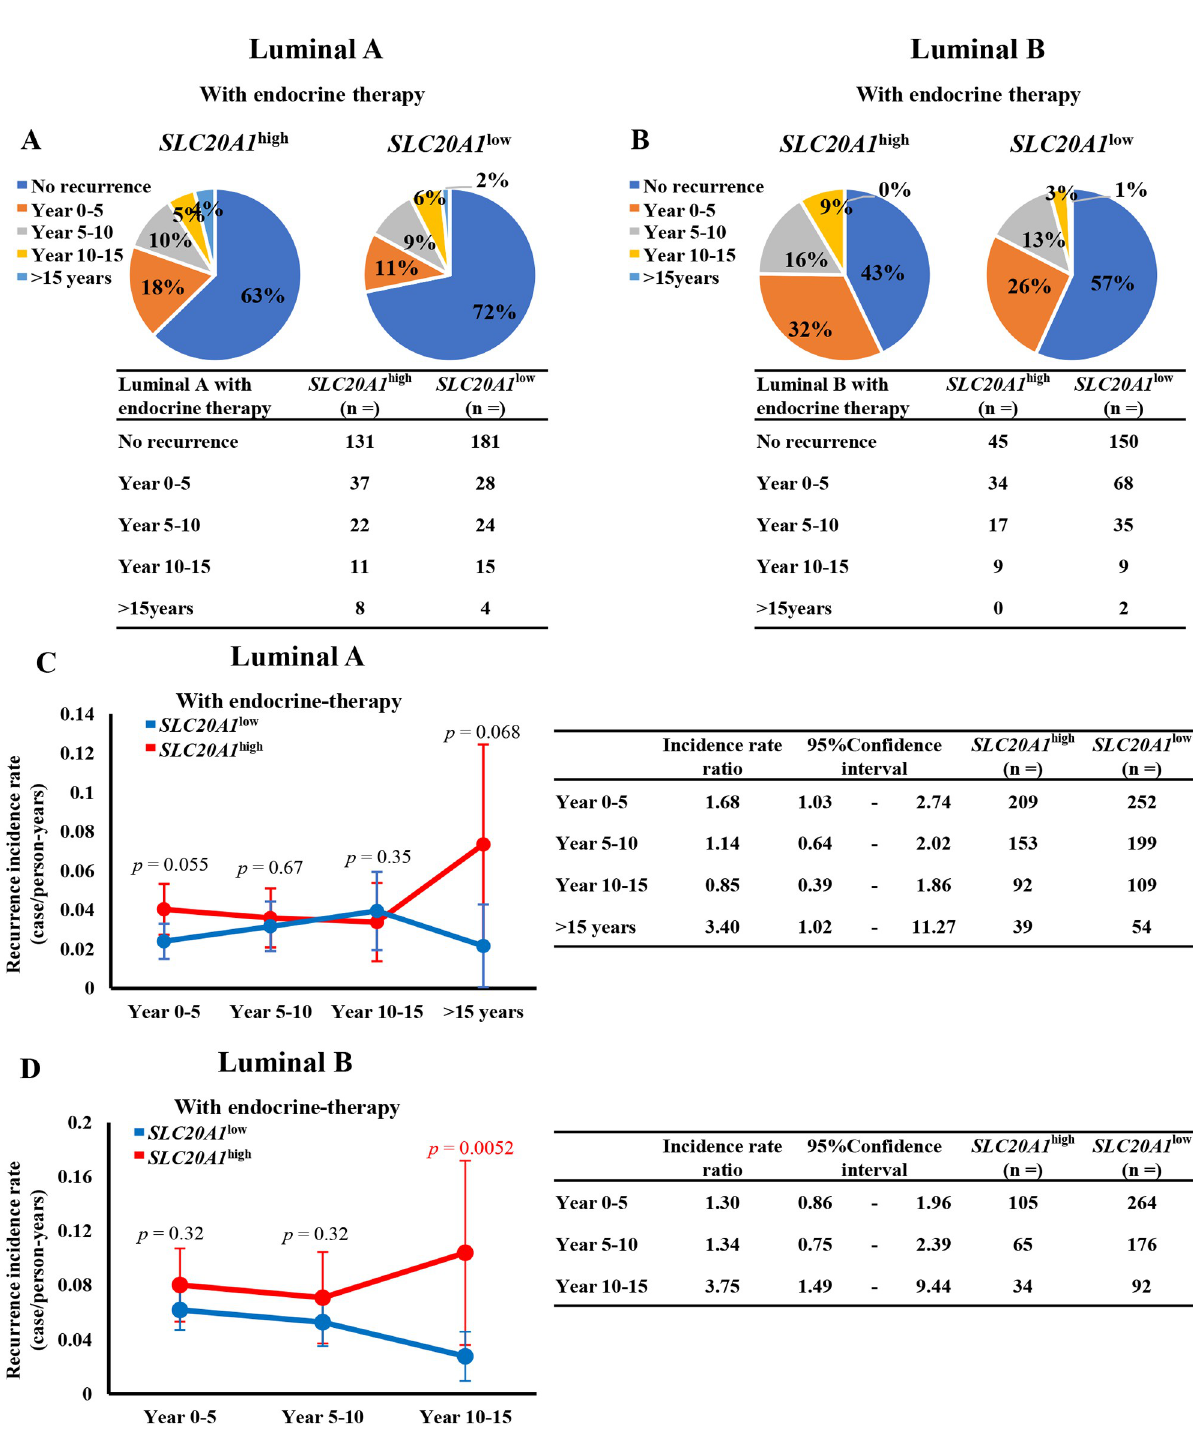
PLOS ONE | https://doi.org/10.1371/journal.pone.0268799 May 23,